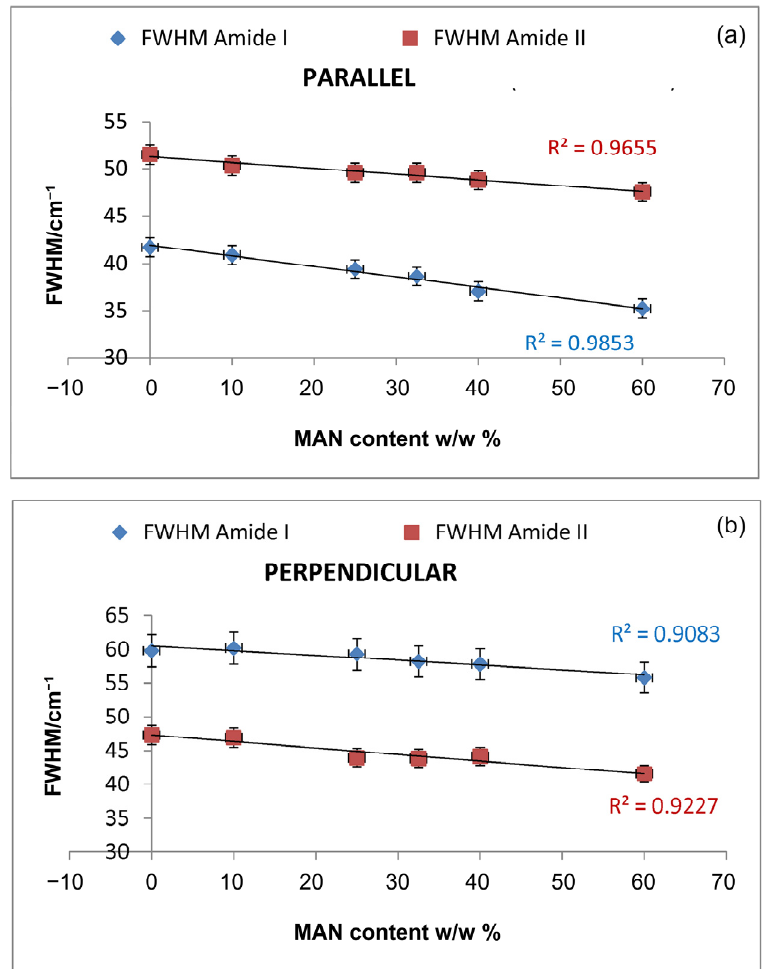
Figure 7. Trend of the FWHM of Amide I and II bands as a function of the weight gain (i.e., MAN content w / w %) in the parallel ( a ) and perpendicular ( b )